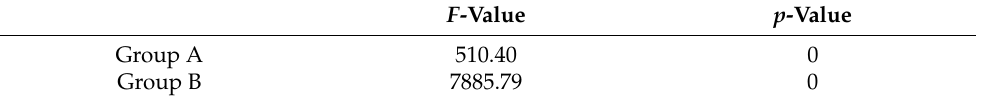
Table 4. The air permeability of non-perforated and perforated RRMPAs.